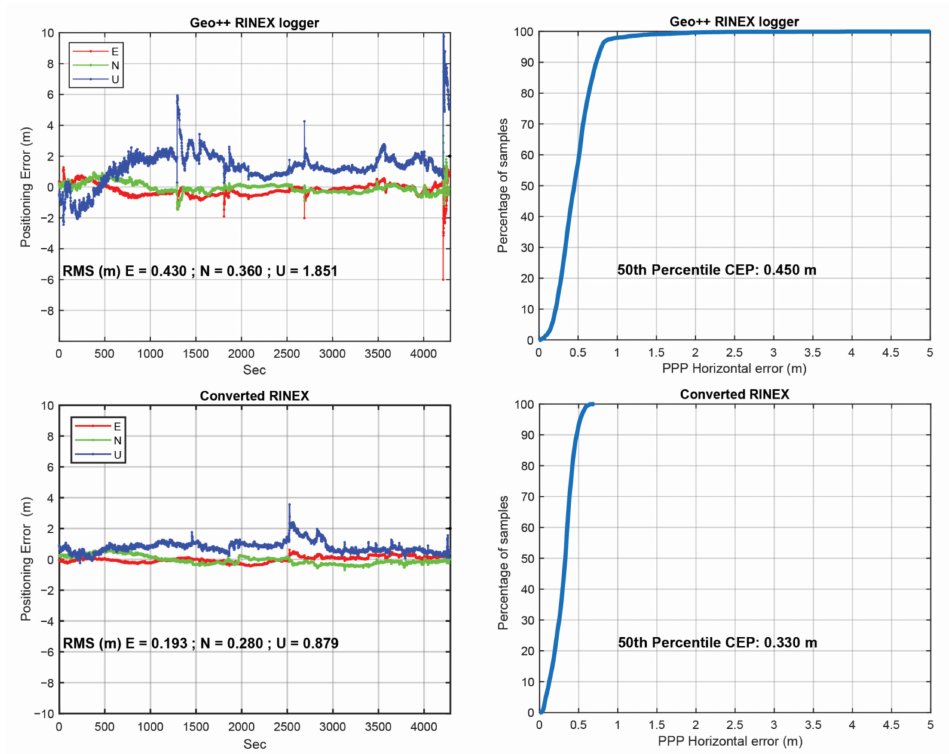
Figure 12. Horizontal positioning errors from Geo++ RINEX logger output and converted RINEX ( left ), cumulative distribution function plot for horizontal positioning error from Geo++ RINEX logger output and converted RINEX ( right